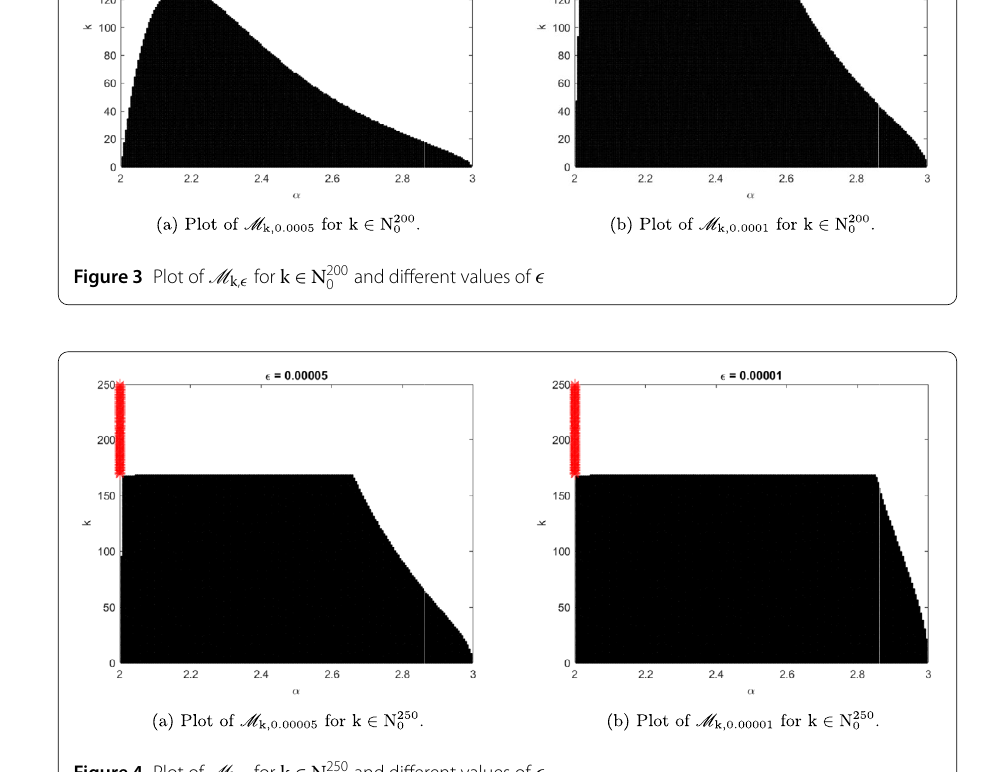
Figure 4 Plot of M k , (cid:4) for k ∈ N 250 0 and different values of (cid:4)